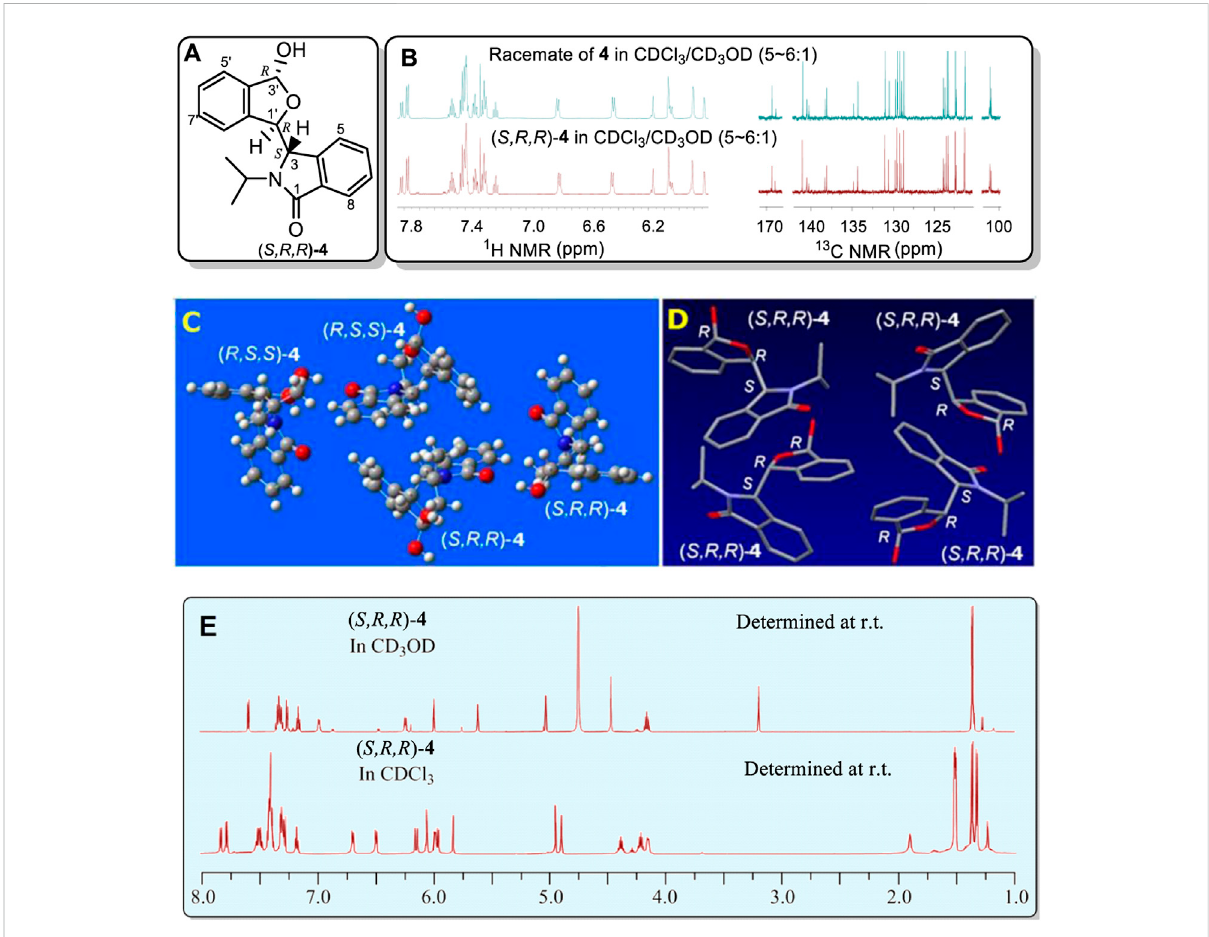
FIGURE 2 (A) Structureof( S,R,R )- 4 . (B) Partial sectionsofthe 1 Hand 13 CNMRfortheracemateof 4 inCDCl 3 /CD 3 ODmixturesolvent(v/v,5 – 6:1)(top)and the single enantiomer, ( S,R,R )- 4 , (bottom) in a CDCl 3 /CD 3 OD mixture solvent (v/v, 5 – 6:1). (C) X-ray structure of racemic 4 . Two ( R,S , S )- 4 and two ( S,R , R )- 4 molecules occupy one unitcell. The corresponding bonds ofthese two con fi gurations had the same bond lengths. (D) Four conformers of ( S,R,R )- 4 were included in the unit cell. These four which have identical bond lengths (H atoms are hidden for clarity) in the solid structure. (E) Comparison of the 1 H NMR spectrum at room temperature of single enantiomer ( S,R,R )- 4 in CD 3 OD with that in CDCl 3 . The signals at 3.21 and 4.75 ppm are due to CH 3 OH in the CD 3